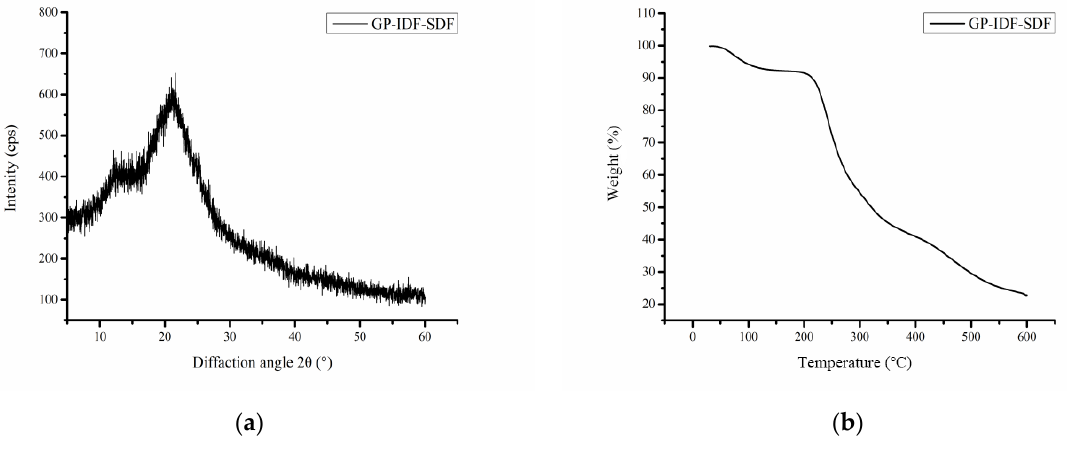
Figure 2. Scanning electron micrographs of GP-IDF-SDF collected at 100× ( a ) and 500× ( b ) magnifi- cations.